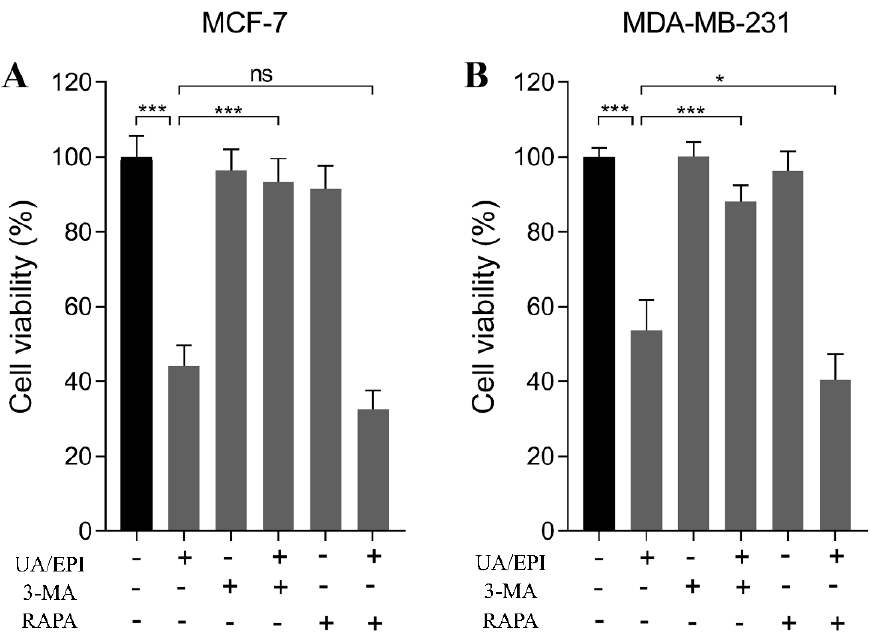
Figure 4. The effects of UA/EPI on autophagy of MCF-7 and MDA-MB-231 cells. MCF-7 ( A ) and MDA-MB-231 ( B ) cells were pre-treated with or without 3-MA (1 mM) or RAPA (10 ng/mL) for 4 h, followed by UA/EPI incubation for another 24 h. * p < 0.05 and *** p < 0.001. The value bars with ns are not significant.